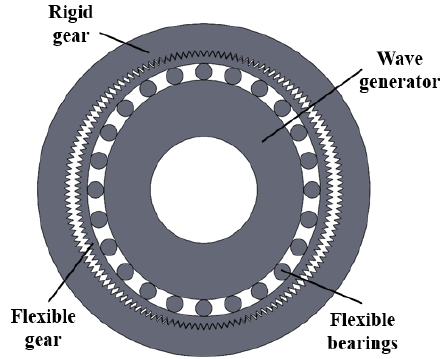
Figure 2. Structural schematic of harmonic reducer.